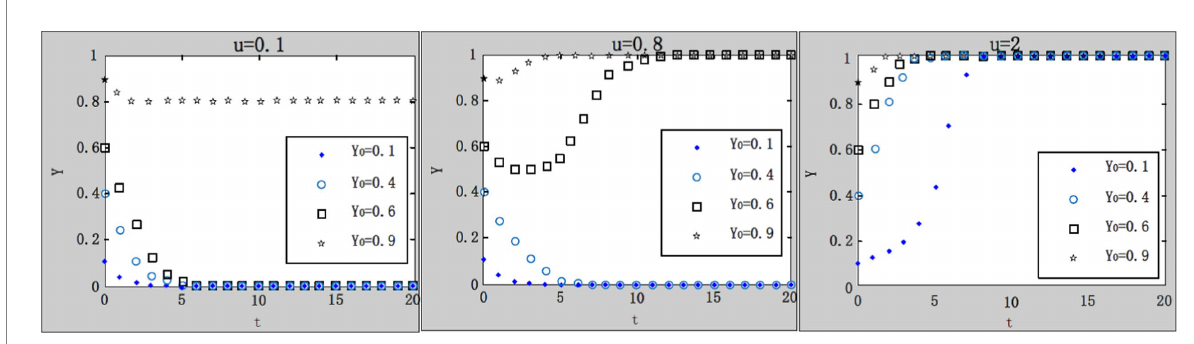
FIGURE 7 Influence of local government’s ex ante penalties on system